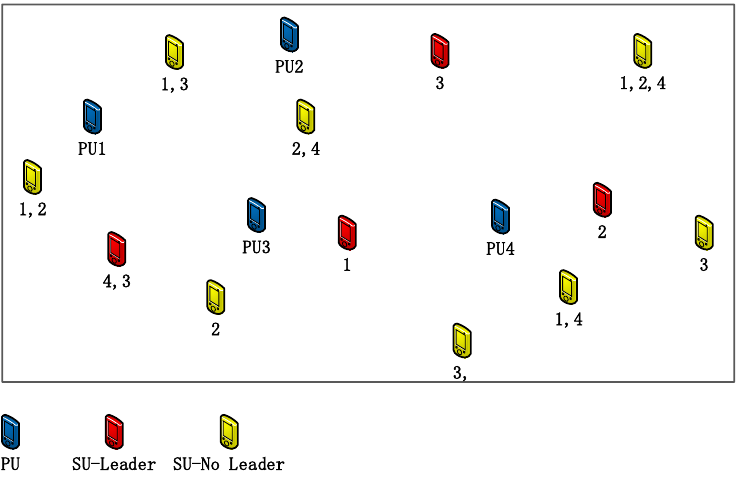
Figure 3. Distributed CSS Model Diagram.